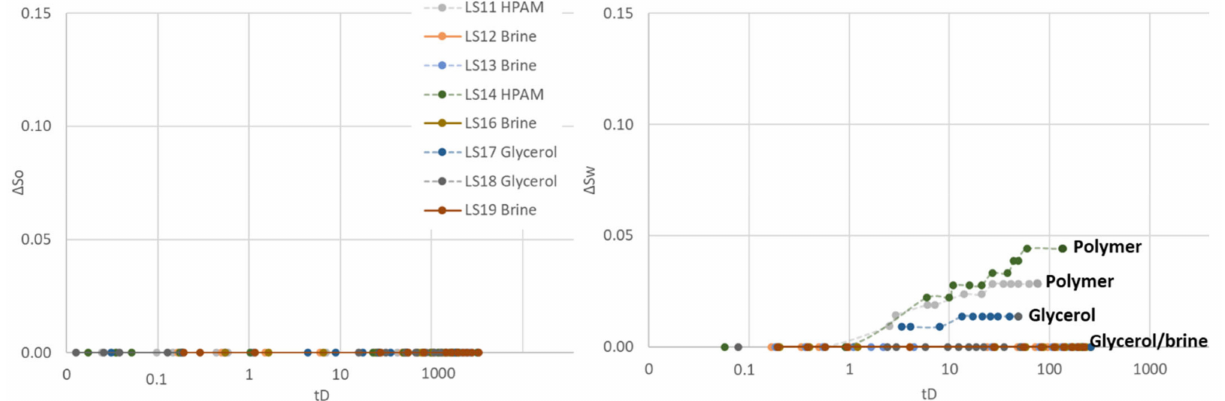
Figure 5. Spontaneous saturation development as functions of dimensionless time during the third Amott–Harvey cycle. Cores were placed in imbibition cells with oil and brine, glycerol, or polymer solution. ( Left ): Oil saturation ( ∆ S o ) during spontaneous oil imbibition, and ( Right ): Water saturation ( ∆ S w ) during spontaneous aqueous phase imbibition. Note that the y -axis only represents a part of the mobile saturation range. The scale is kept constant for all cycles, to enable simple comparison of results.